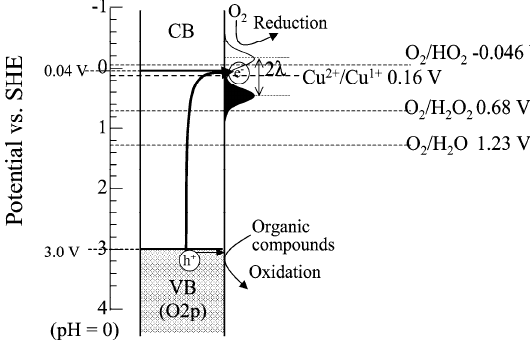
Figure 5. Mechanism for the generation of photocatalytic activity of Cu(II)/TiO 2 under visible light. Visible light irradiation induces interfacial charge transfer (IFCT) from the valence band (VB) of TiO 2 to the Cu 2+ ion. Reprinted with permission from [82]. Copyright American Chemical Society, 2009.